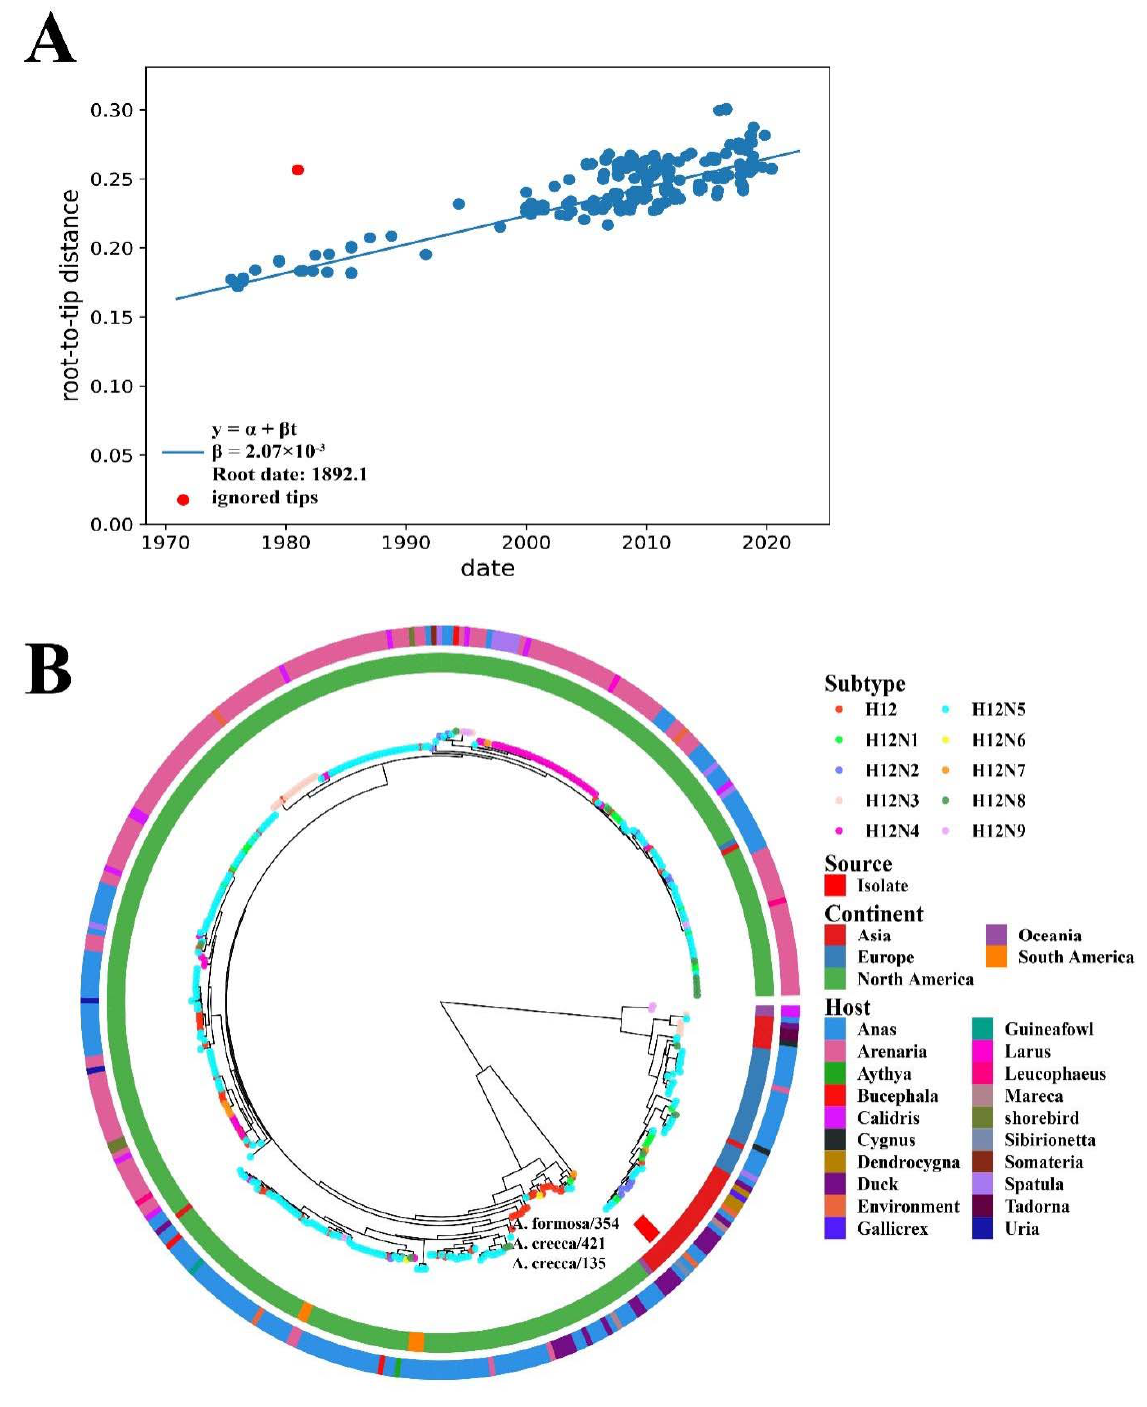
Figure 2. Phylogenetic analysis of HA genes of H12 IAVs. ( A ) The temporal signal was estimated. The regression line (slope in blue) represents the average evolutionary rate and is displayed as root-to-tip distance. ( B ) HA genes of the three H12 viruses detected in wild birds in the study and 398 HA genes of H12 viruses obtained from the GISAID and NCBI were analyzed. The MCC tree was analyzed using TreeAnnotator with common ancestor heights following the burn ‐ in of the first 10%. The phylogenetic tree was plotted and visualized using ggtree and ggtreeExtra in R.